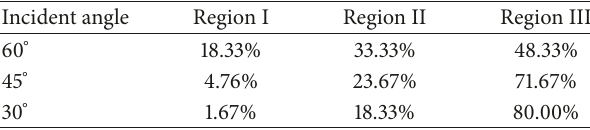
Table 4: Projectile mass fraction of debris